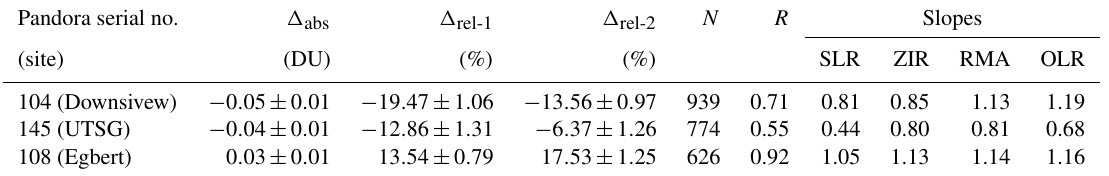
Table A4. TROPOMI ECCC vs. Pandora total column NO 2 , using the wind-based method. Pandora serial